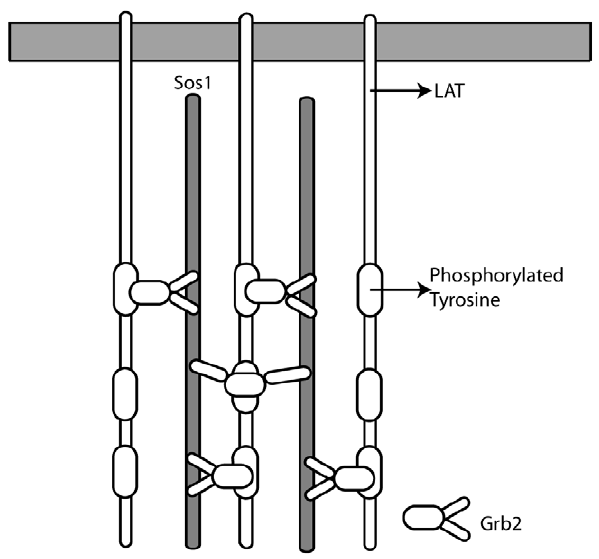
Figure 9. Crosslinking of Sos1 molecules by Grb2 at the